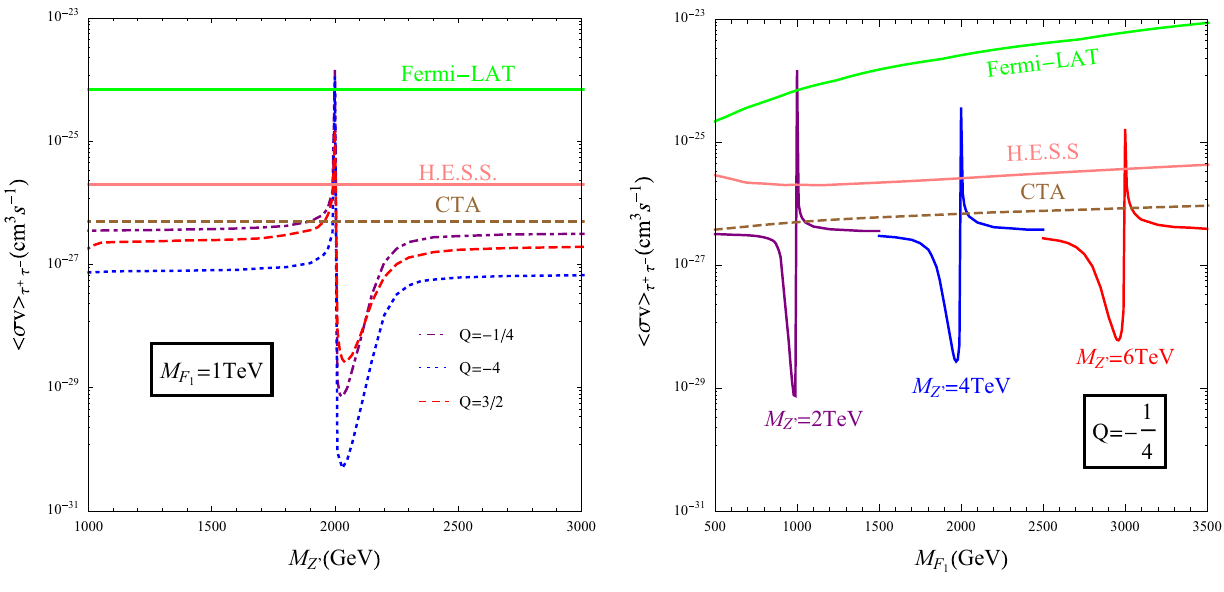
Fig. 11 Same as Fig. 10, but for fermion DM F 1 radiation, DM relic density, direct and indirect detection for some benchmark scenarios. Based on the benchmark results, a scanning of the resonance region M DM (cid:5) M Z (cid:2) / 2 is then carried